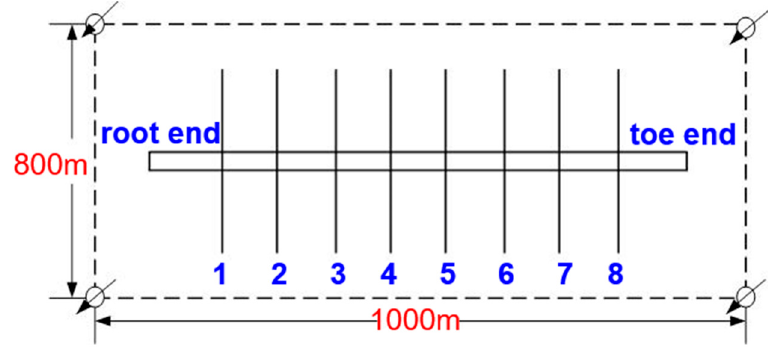
Figure 4. Scheme of staggered five spot water-injection model.